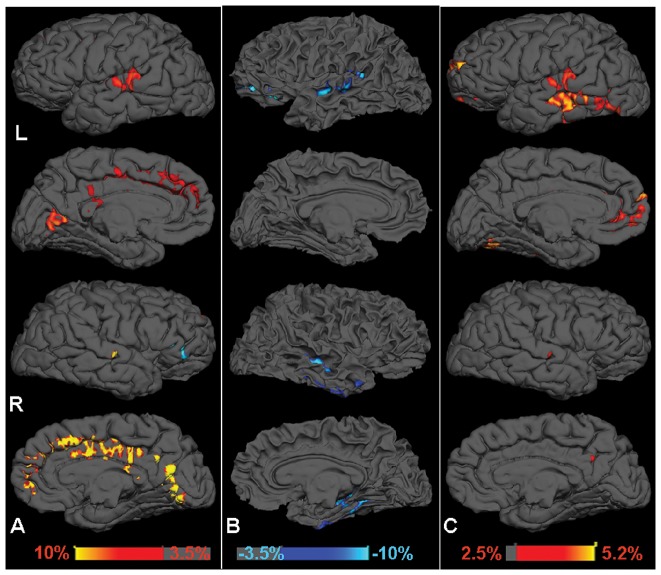
Regions with significant volume percentage increment (A, red color) in gray matter, and volume decrement in gray matter (A, blue color) as well as white matter volume reduction (B, blue color) in autism compared to controls (P<0.01).Significant cortical thickness increment in percentage change in autism compared to controls is shown in C with red color (P<0.01). Both medial and lateral views on sagittal surface in the left and right hemispheres of an individual control subject are shown for gray matter volume (A), white matter volume (B) and cortical thickness (C) comparison between autistic children and controls. The percentage change of volume in autism was calculated as the mean difference between volumes of two groups normalized with individual supratentorial volume and scaled by the mean normalized volume of control group.